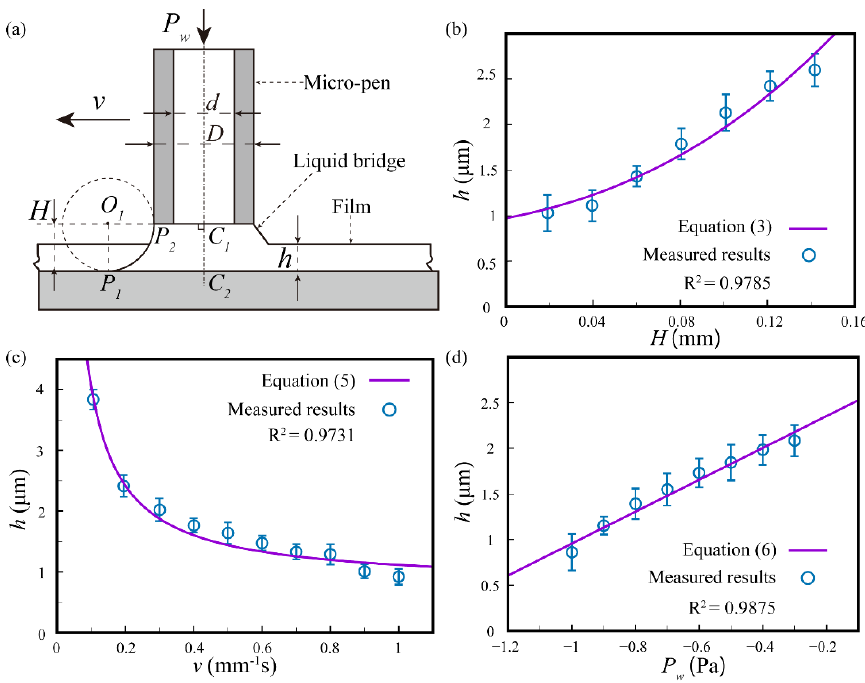
Figure 2. Effect of the micro-pen writing parameters on the PVA film thickness. ( a ) Schematic diagram of the micro-pen writing process. ( b ) Effect of the writing gap H on the film thickness. ( c ) Effect of the substrate moving velocity v on the film thickness. ( d ) Effect of the working pressure P w on the film thickness.